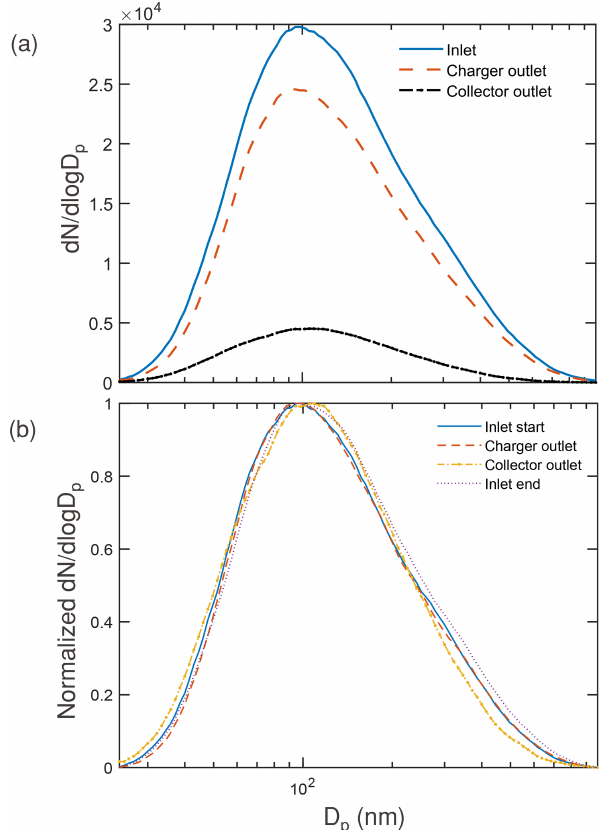
Figure 3. (a) Particle size distribution measured at the inlet aver- aged from that before and after collection, at the charger outlet av- eraged from that before and after collection, and at the outlet of the collector. (b) Normalized particle size distribution measured for the inlet before staring the experiment, at the outlet of the charger, at the outlet of the collector, and the inlet at the end of the experiment (to determine any bias in the